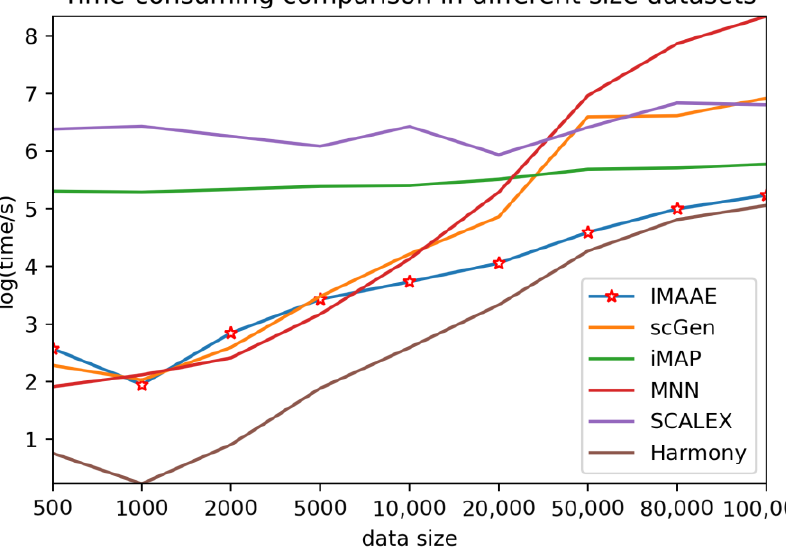
Figure 10. Comparison of the time performance of IMAAE with other methods on different-size simulation datasets.